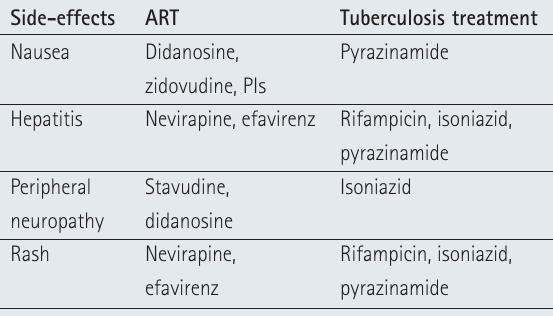
Shared side-effects of TB and ART are set out in Table VIII. TABLE VIII. SHARED SIDE-EFFECTS OF TB AND